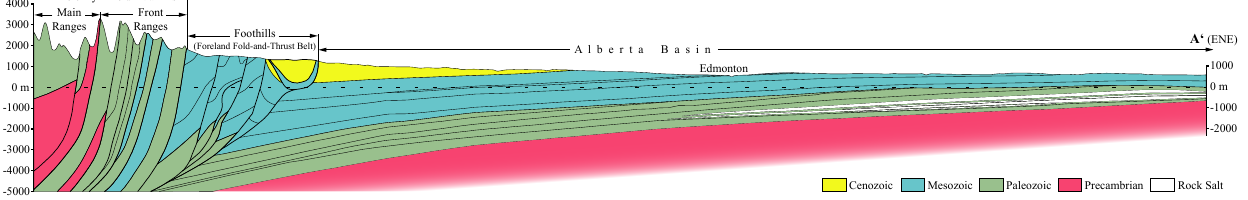
Figure 3. Cross section across Alberta in west–southwest to east–northeast orientation; the trace is highlighted in Figs. 2 and 4. Visible is the Alberta Basin as a wedge-shaped retro-arc foreland basin, together with parts of the Rocky Mountains and the foreland fold-and-thrust belt (foothills) in between. The rock units are roughly indicated by the stratigraphic age. Additional thick rock salt units are indicated separately, because of their potential to detach the stress field. The vertical exaggeration is 10 times, redrawn after Hamilton et al. (1999).